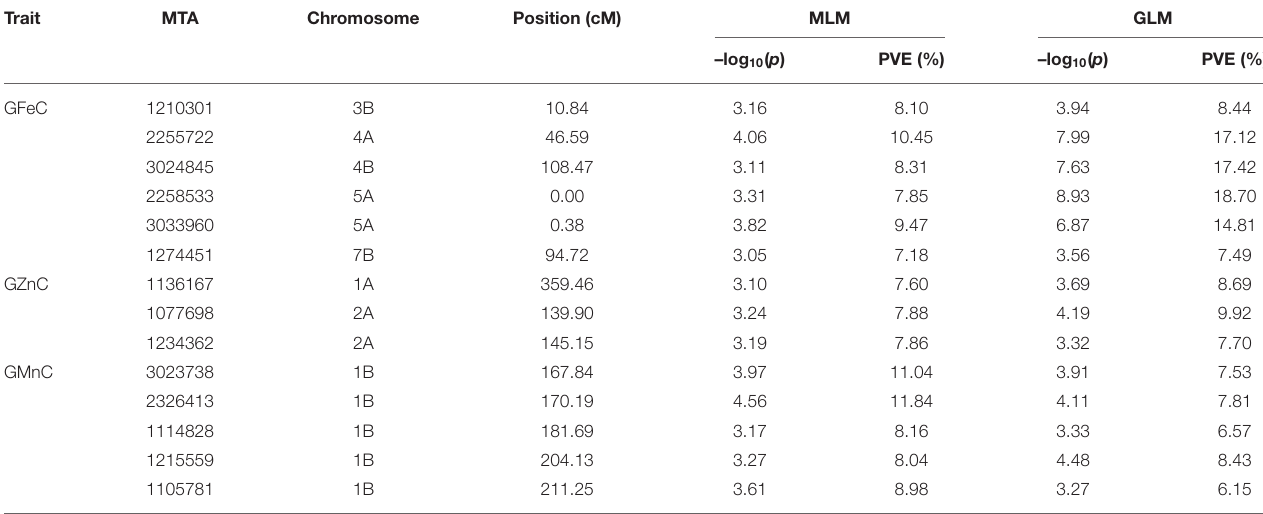
TABLE 4 | Significant high-confidence MTAs for GFeC, GZnC, and GMnC identified by MLM and GLM. Trait MTA